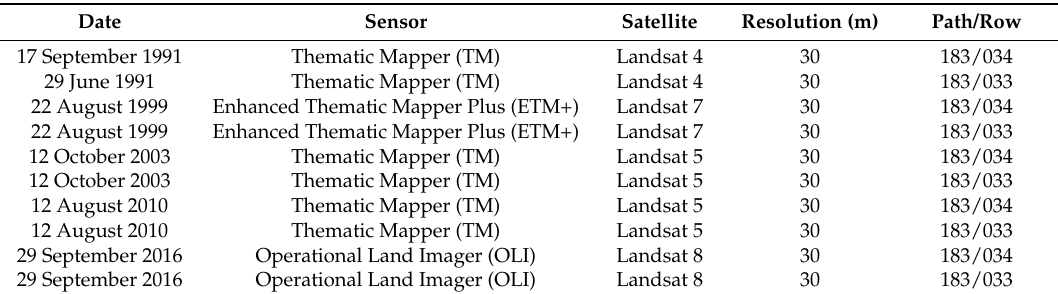
Table 1. The characteristics of the satellite images used as the primary data to perform the change detection analysis.